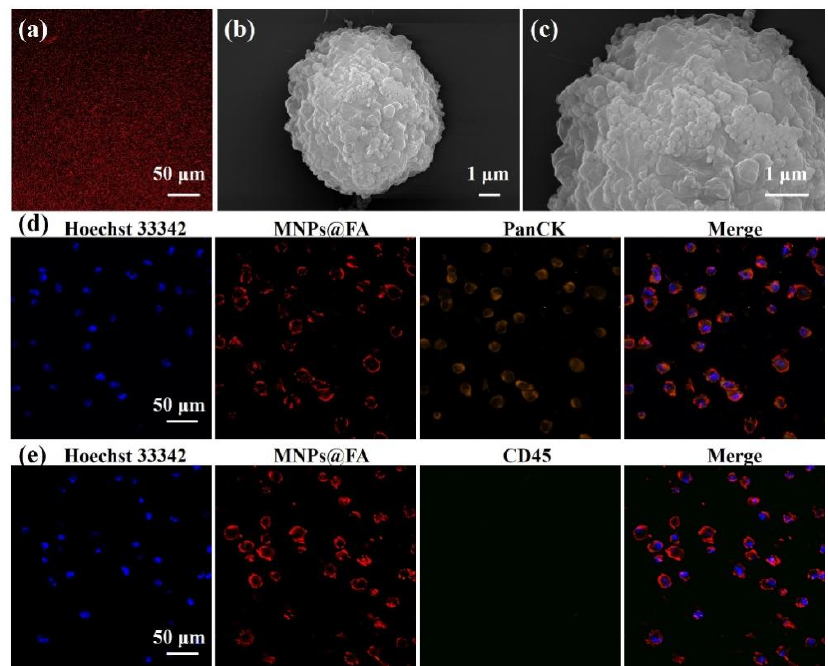
Figure 3. ( a ) A fluorescent image of MNPs@FA showing a stable fluorescent signal. ( b , c ) SEM images of an SK-OV-3 cell captured by MNPs@FA with a sufficient number of nanoparticles on the cell surface. ( d ) Fluorescent images of SK-OV-3 cells captured by MNPs@FA (red) with immunostaining of anti-PanCK-555 (orange) and Hoechst 33,342 (blue). ( e ) Fluorescent images of SK-OV-3 cells captured by MNPs@FA (red) with immunostaining of anti-CD45-488 (green) and Hoechst 33,342 (blue).